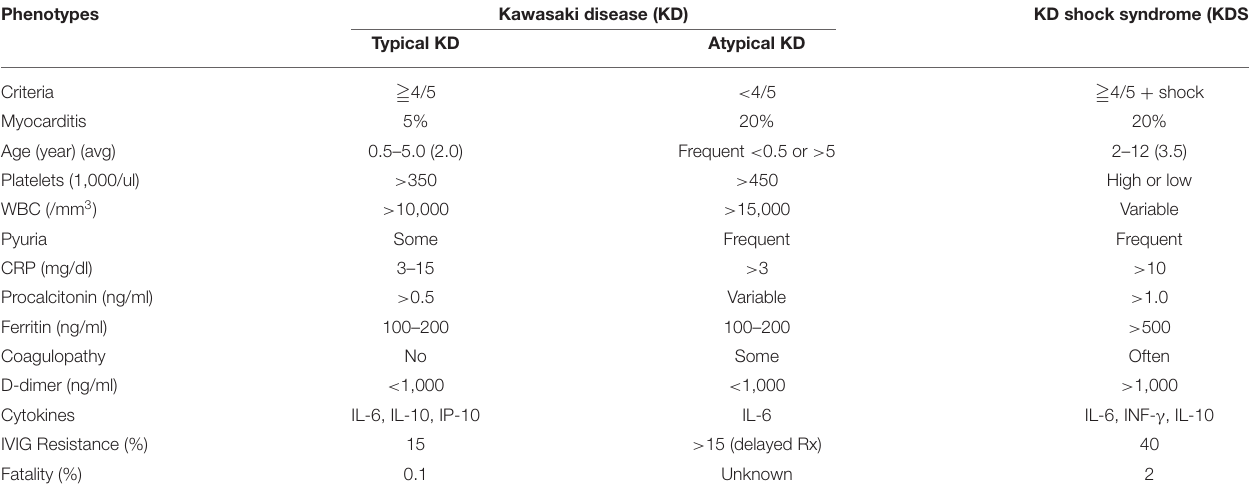
TABLE 1 | Different phenotypes and characters of Kawasaki